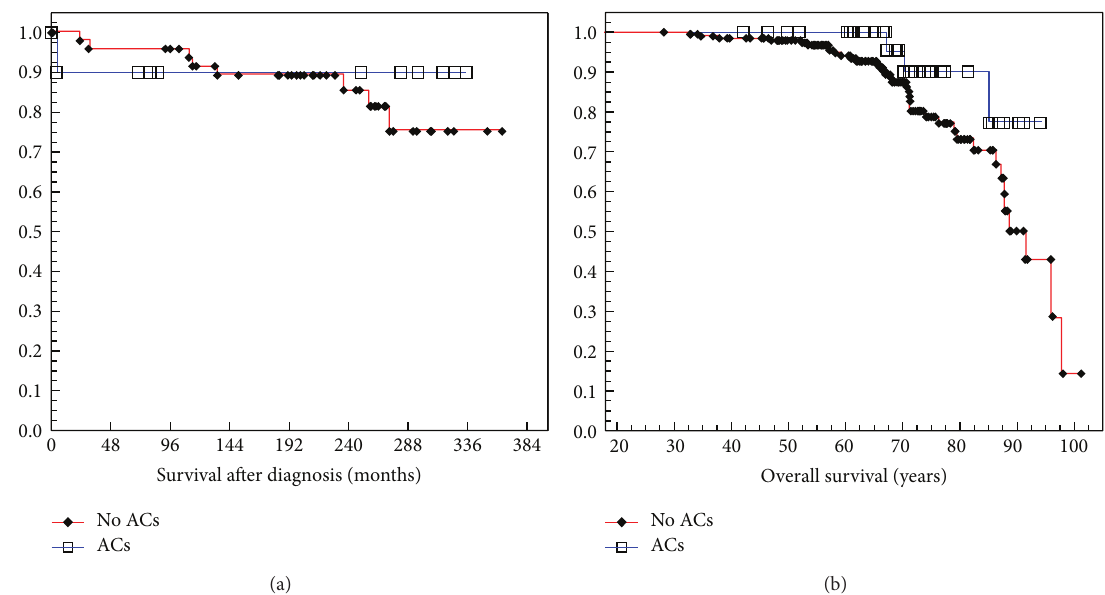
Figure 1: (a) Kaplan-Meier estimates of survival after hemochromatosis diagnosis in probands with and without autoimmune conditions (ACs) ( 𝑝 = 0.6380 ; log-rank test). (b) Kaplan-Meier estimates of overall survival of hemochromatosis probands with and without ACs ( 𝑝 = 0.1127 ; log-rank